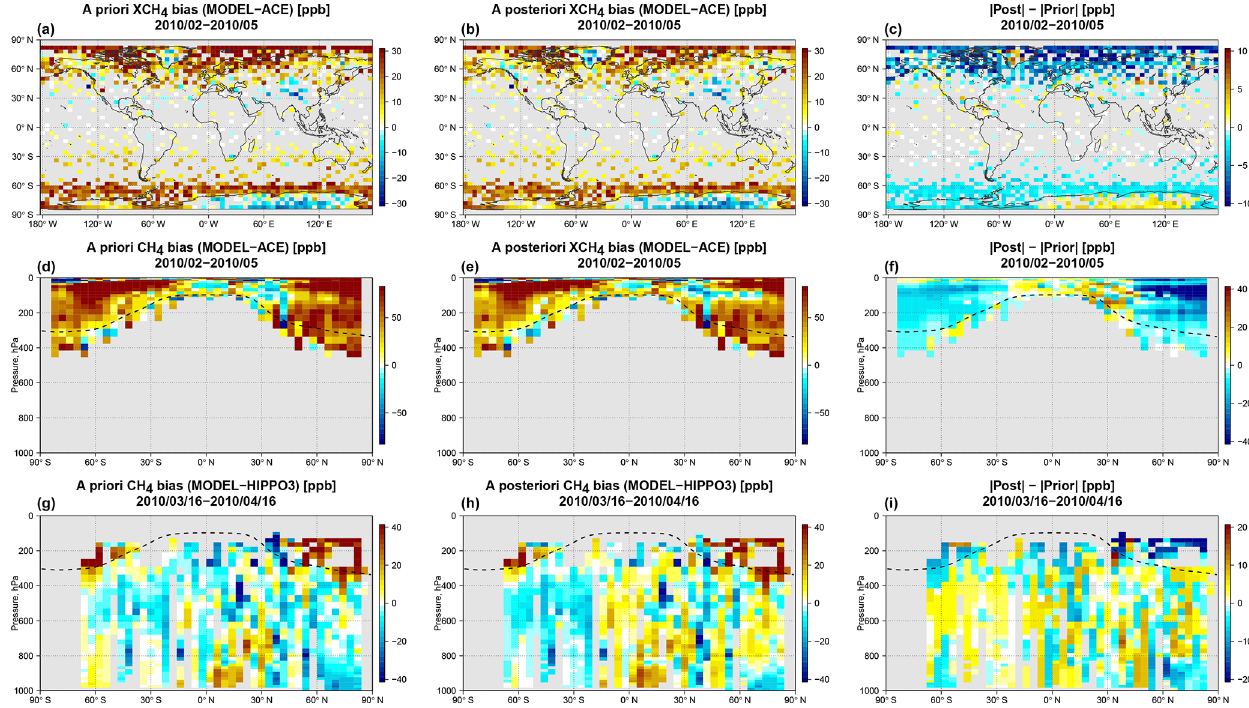
Figure 10. Evaluation of the mean (February–May 2010) a priori and WC_4x5 optimized CH 4 fields using ACE-FTS and HIPPO-3 CH 4 measurements. Shown are (a, d, g) the a priori bias, (b, e, h) the a posteriori bias, and (c, f, i) the reduction in absolute bias. (a–c) XCH 4 bias between GEOS-Chem and ACE-FTS. (d–f) Zonally averaged CH 4 bias between GEOS-Chem and ACE-FTS. (g–i) CH 4 bias between GEOS-Chem and HIPPO-3. We used ACE-FTS retrievals only in the stratosphere. The XCH 4 bias between GEOS-Chem and ACE-FTS was obtained by augmenting the ACE-FTS profile in the stratosphere with the GEOS-Chem profile in the troposphere and smoothing the vertical CH 4 profile with mean meridional GOSAT averaging kernels. The dashed line represents the mean tropopause